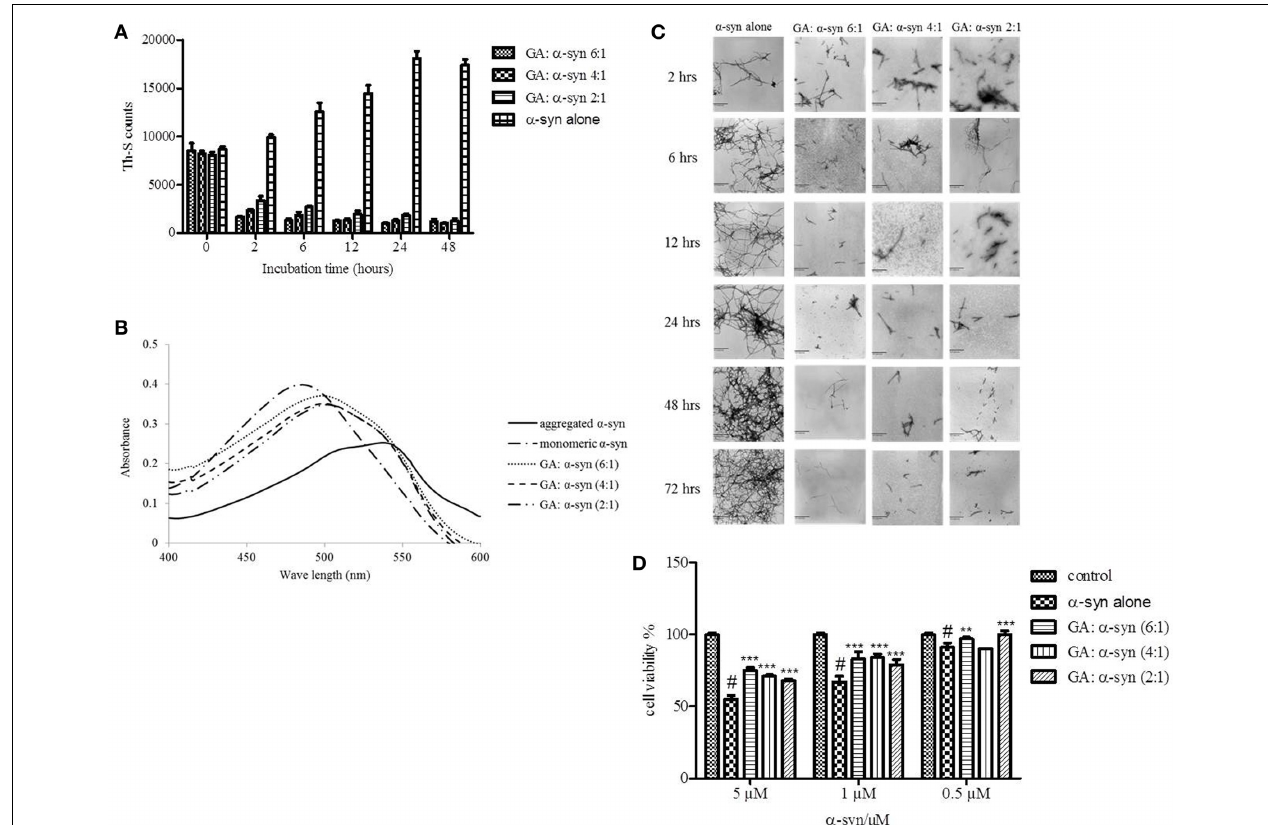
FIGURE 3 | GA disaggregates preformed α -syn fibrils in a concentration-dependent manner. (A) Samples of aggregated α -syn were incubated for 48h at 37 ◦ C in the absence or presence of various concentrations of GA (GA: α -syn 6:1, 4:1, 2:1). The fibril content was then measured by the Th-S binding assay. The assays were performed in triplicate (average of triplicate measurements ± standard deviations). (B) Congo red binding to samples of pre-aged α -syn (25 μ M) incubated alone or in the presence of GA (molar ratio of GA: α -syn 6:1, 4:1, 1:1) for 72h with continuous shaking at 37 ◦ C. Samples of α -syn (5 μ M) incubated alone or with GA at different molar ratios were mixed with Congo red, at a final concentration of 5 μ M. The reaction samples were thoroughly mixed and placed in a 10mm quartz cuvette. The UV absorbance spectra were recorded from 400 to 600nm. (C) Electron microscopy images of negatively stained